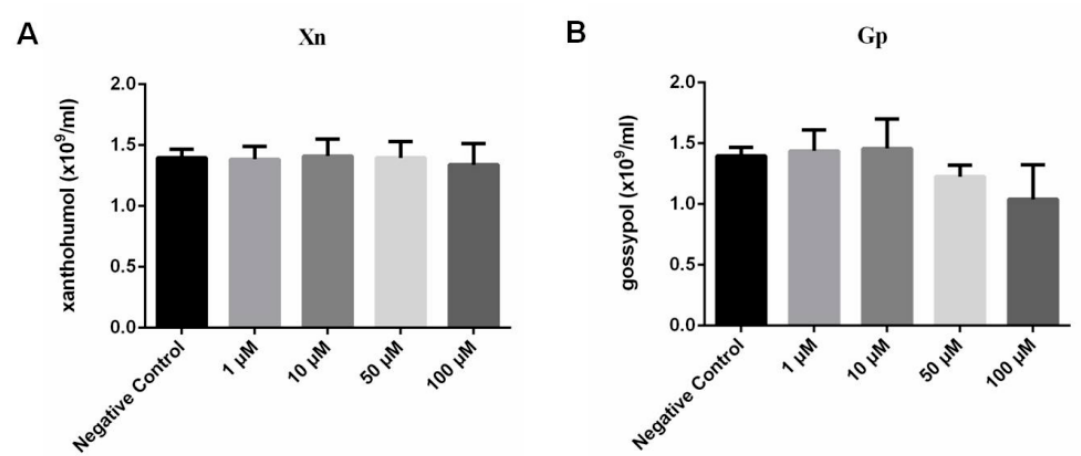
Figure 6. The cytotoxicity assay of xanthohumol ( A ) and gossypol ( B ). The negative control was treated with medium without drugs.